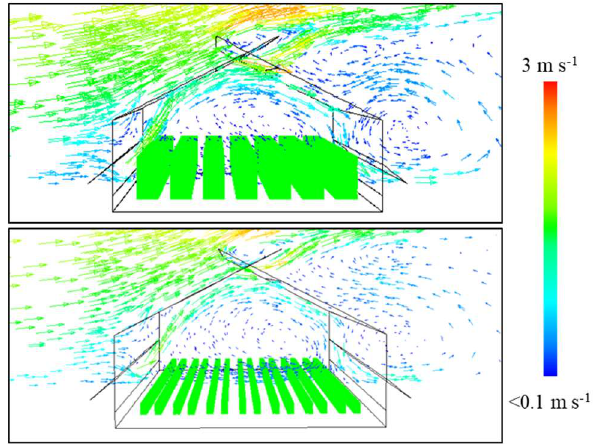
Figure 10. Airflow pattern of the greenhouse according to tomato crop height in the RTG (wide-span greenhouse; vector field). Table 8. Evaluation of C d of a wide-span greenhouse according to wind and tomato plant